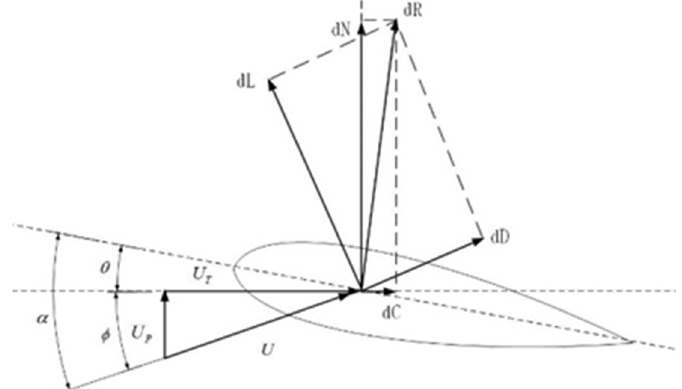
Figure 19. Airfoil profile force diagram.